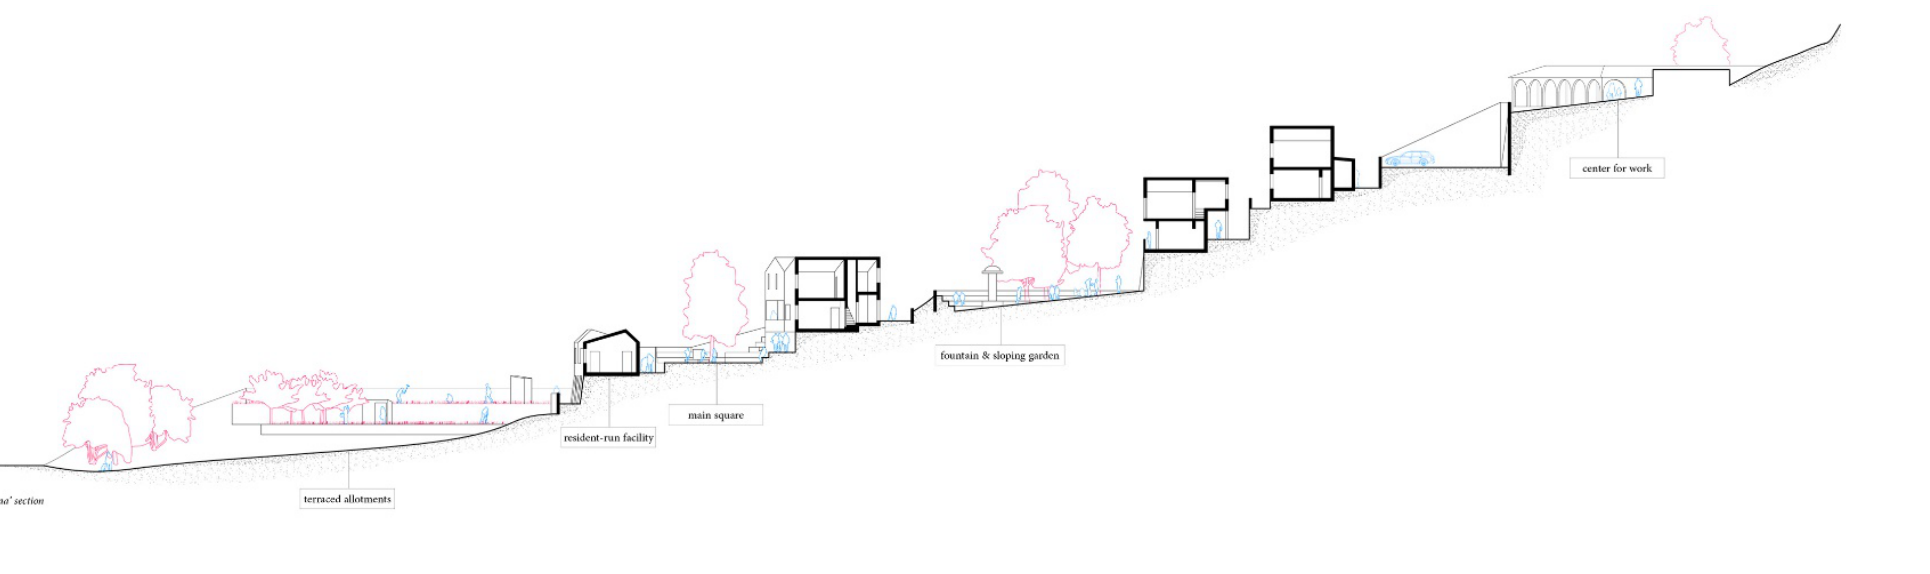
Figure 13: Some examples of the designed spaces and interventions: a section of the housing